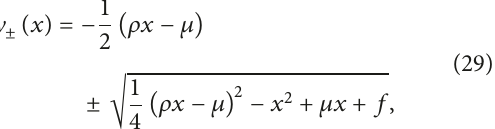
Figure 11: The orbit on Γ 5,3,−5